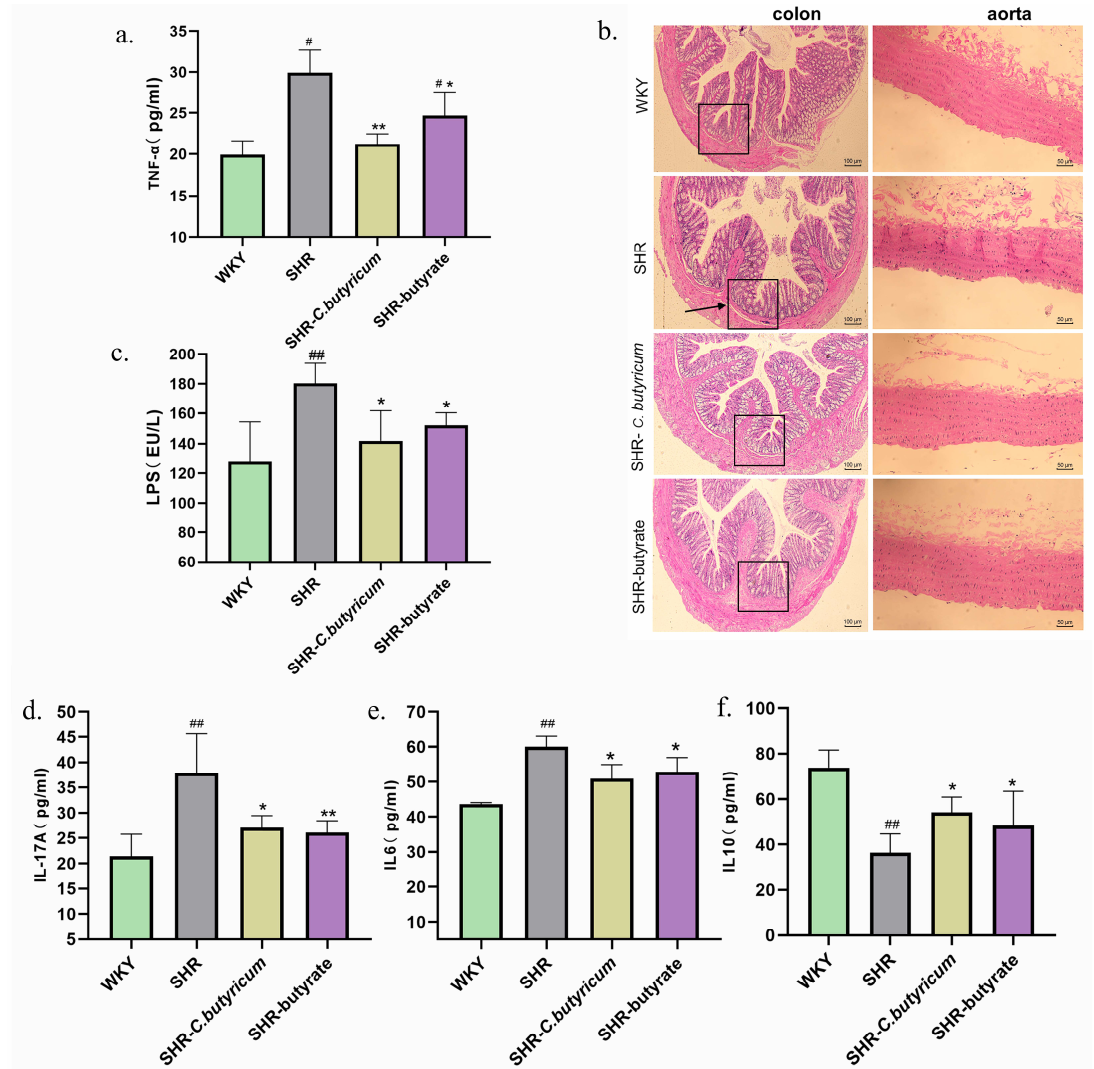
Figure 4. Inflammation of SHR is reduced by C. butyricum and butyrate. ( a , c – f ) C. butyricum and butyrate regulated cytokine levels ( a , TNF- α ; c , LPS; d , IL-17A; e , IL-6; f , IL-10; n = 3 per group). ( b ) H&E staining of the colon and aorta. Data are shown as the mean ± S.E.M., * p < 0.05, ** p < 0.01 for SHR vs. SHR- C. butyricum or SHR-butyrate. # p < 0.05, ## p < 0.01 for SHR vs. WKY.